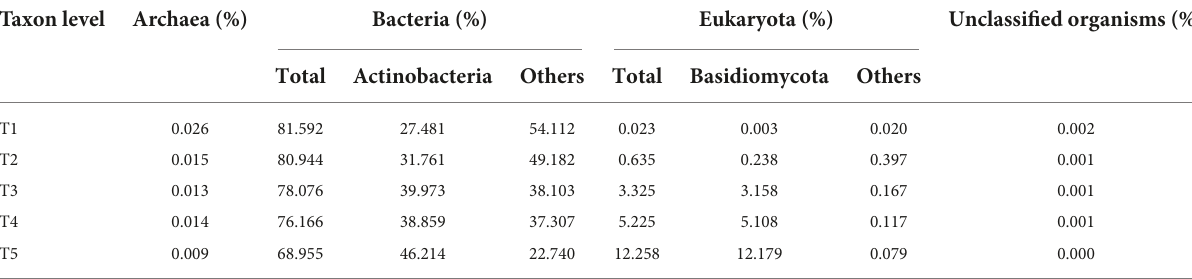
TABLE 2 Taxonomic origin of predicted genes at domain level in the metagenomes of the five time point composting substrate of oyster